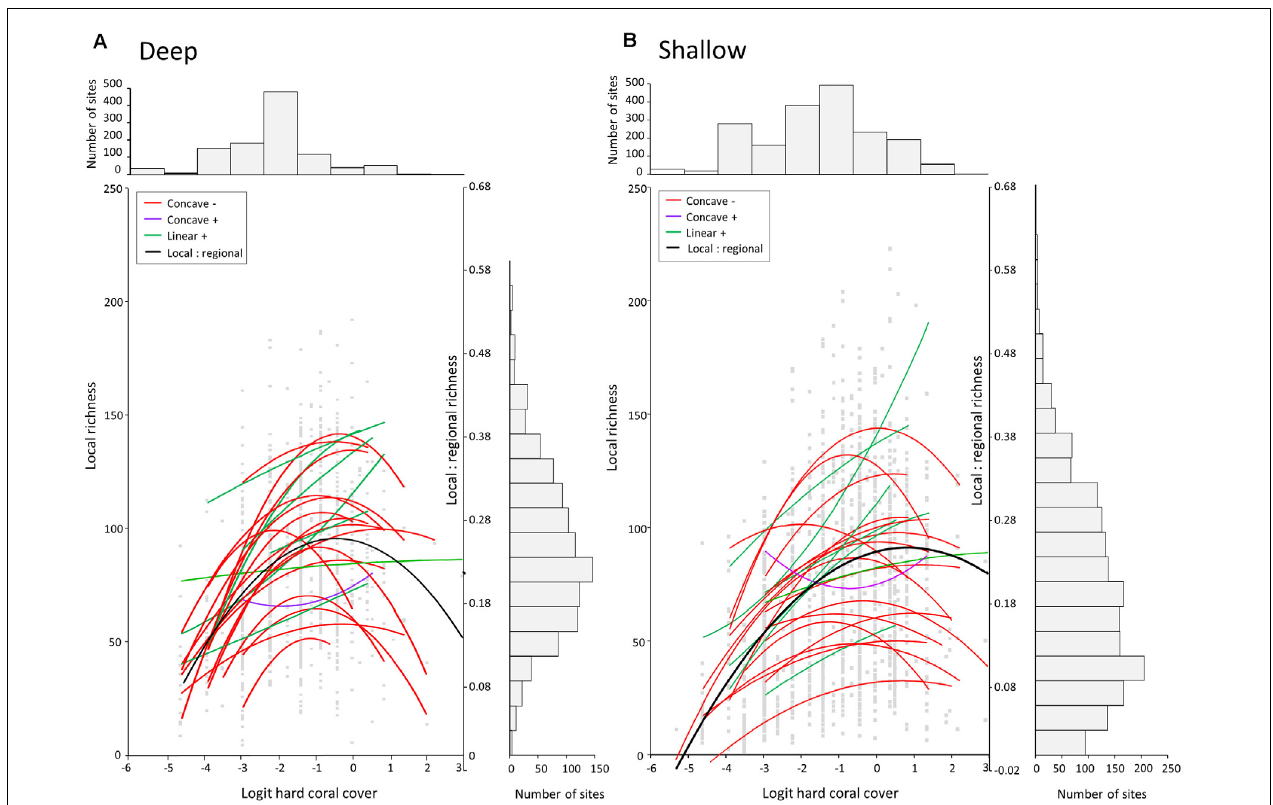
FIGURE 6 | Polynomial regressions of local richness (S L ) with cover of living hard corals (Logit transformed, see Methods) for each ER and overall (solid black line). (A) Deep reef slope and (B) shallow reef slope. Color codes for curves illustrate different forms of the relation. For the overall relation (black line), S L :S R for each site in each ER was plotted against logit cover. Bar graphs illustrate the frequency distributions of S L and coral cover in all sites. Logit cover of 0 is equivalent to 50% cover, negative values are less than 50%, and positive values greater than 50%. For the shallow reef slope, the apparent skewed proportion of sites with low richness (B) , vertical bar graph, is mainly attributable to the large number of sites surveyed on the north-central